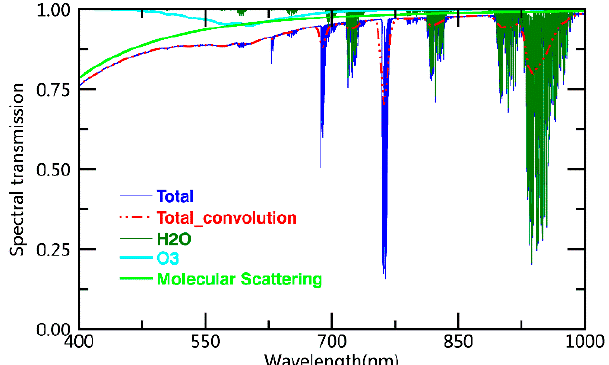
Figure 12. Spectra of the components of atmospheric extinction. Total transmission spectra resulting from the minimal atmospheric extinction (AOD = 0.03) and our radiosonde profiles are shown as a blue solid line. Water vapor, ozone, and molecular scattering are shown as the green, cyan, and lime solid lines, respectively. The total transmission from Equation (3) is shown as the red dash-dotted line.